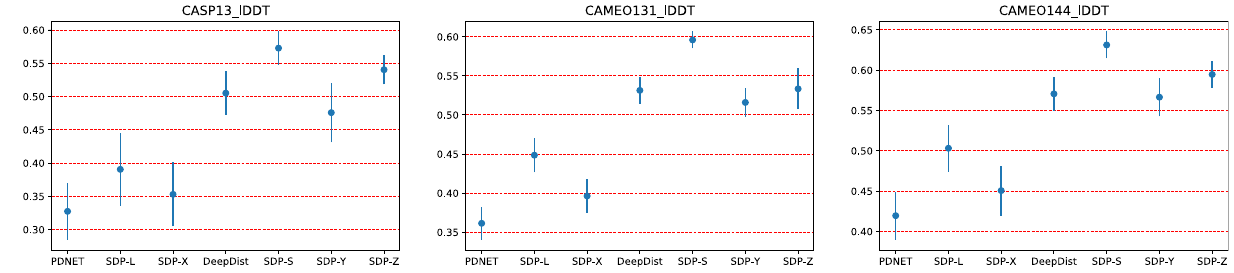
Figure 3. 95% confidence interval plots for lDDT scores of PDNET, DeepDist and SDP methods.